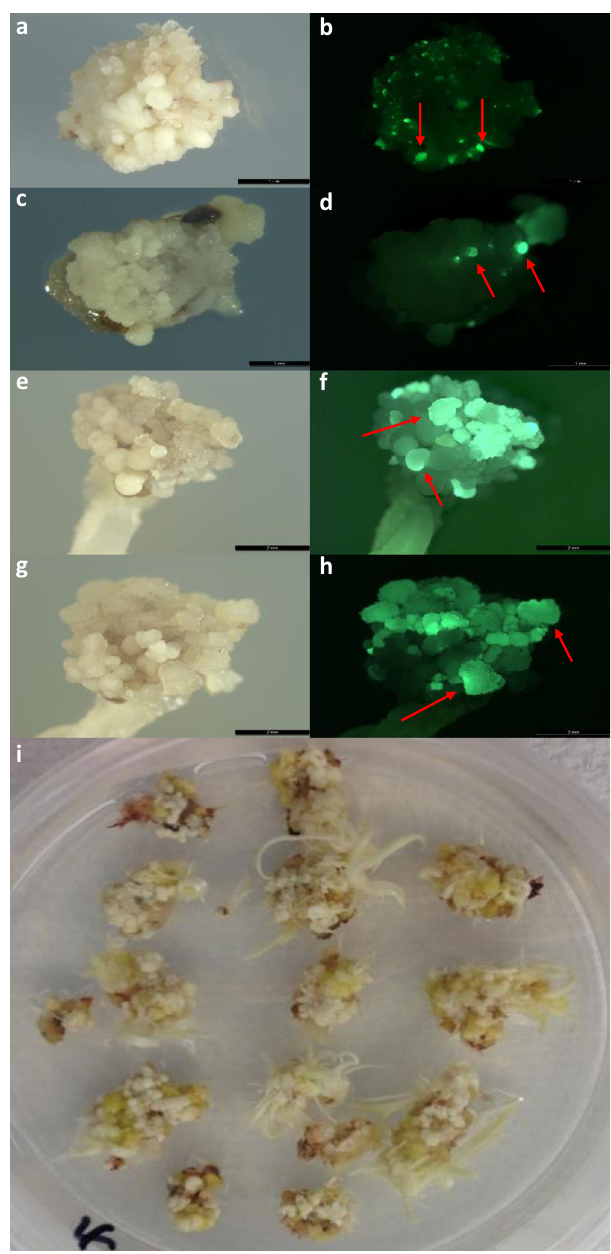
Fig. 2 Somatic embryo formation and regeneration mediated by morphogenic gene excision-induced selection-activation system. Bright fi eld and fl uorescence images of early-stage somatic embryo formation (couple of examples indicated by the arrows) on the surface of immature scutella in Tx430 ( a , b ), Macia ( c , d ), Malisor 84-7 ( e , f ), Tegemeo ( g , h ). a , c , e , and g Bright fi eld images. b , d , f , and h Fluorescence images. i Tx430 shoot regeneration after four-week